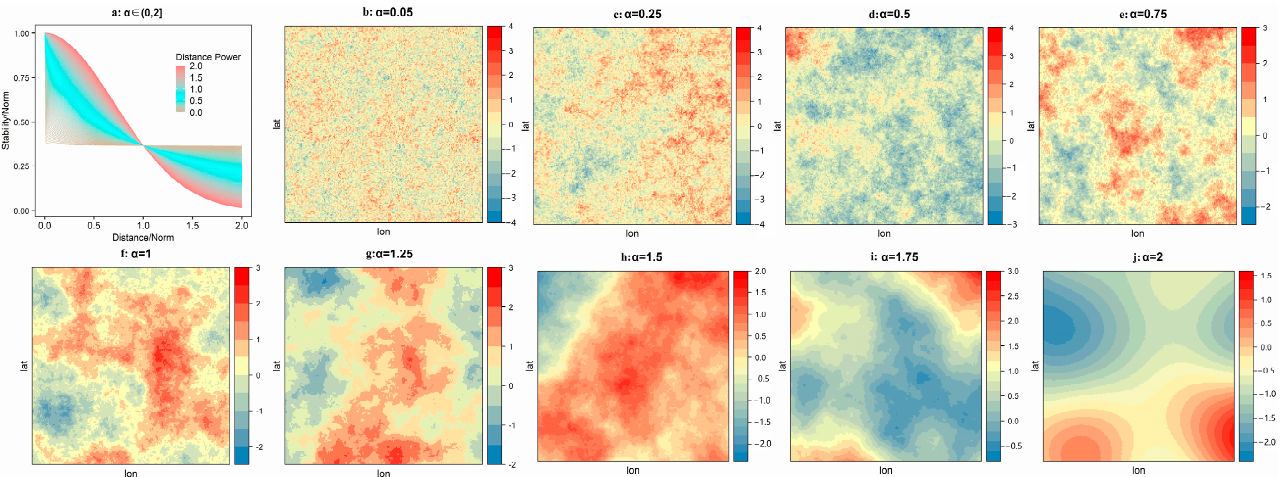
Figure 3. Simulated Gaussian random fields under an exponential spatial covariance function with different values of α .